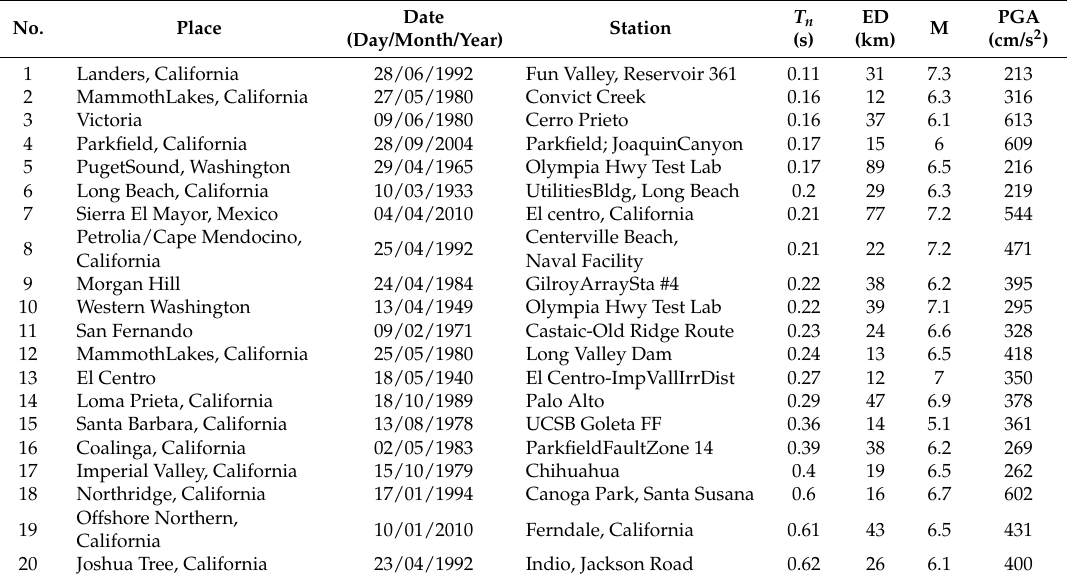
Table 2. Earthquake records, NS component. T n : Elastic period; ED: epicentral distance; M: Magnitude moment; PGA: Peak ground